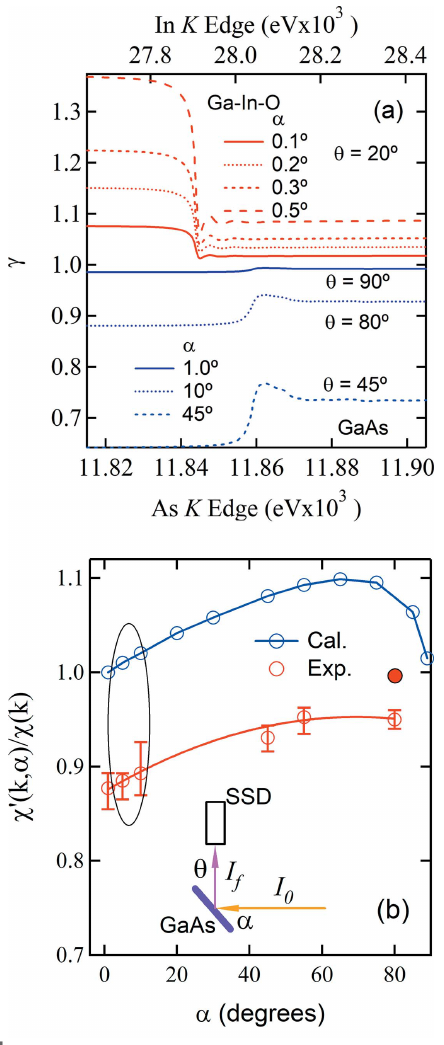
Figure 5 ( a ) Raw data measured on the GaAs powder, simultaneously, through the As K (cid:5) , Ga K (cid:5) and absorption channels at the As K -edge. ( b ) Raw Ga K (cid:5) data measured on the GaAs wafer for various incidence angles. The As K (cid:5) data at (cid:5) = 5 (cid:3) is given to show its correlation with Ga K (cid:5) . The insert shows the details of the secondary emission edge step induced by the As K (cid:5)